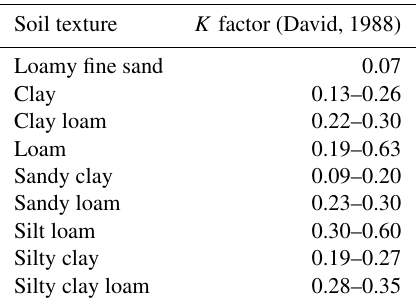
Table 5. K -factor values from David (1988) for soil textures in the